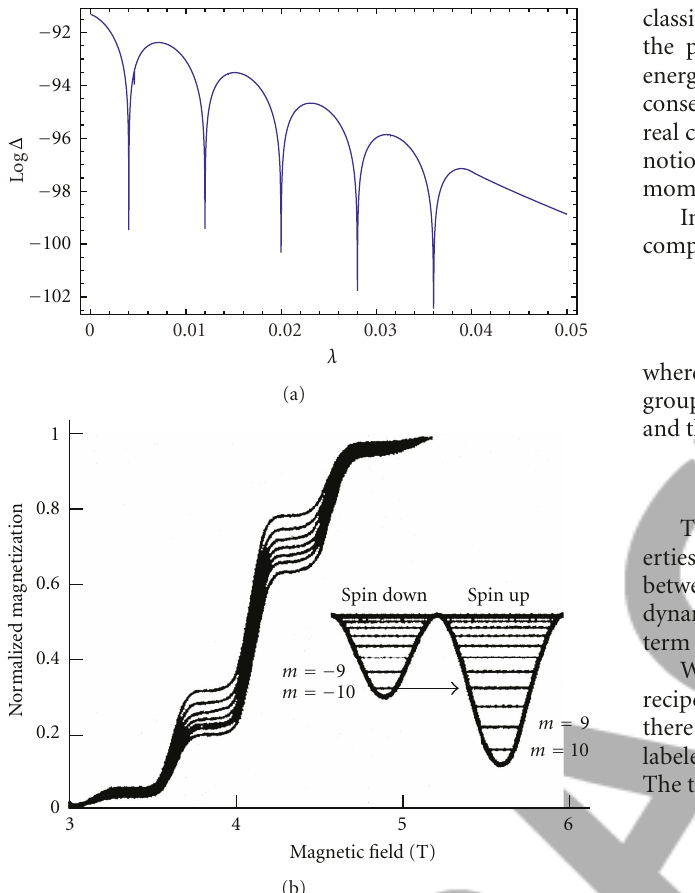
Figure 1: The first curve was obtained from numerical calculation of the tunnel splitting for Mn 12 and the second curve is the magne- tization plot of this magnetic molecule in low